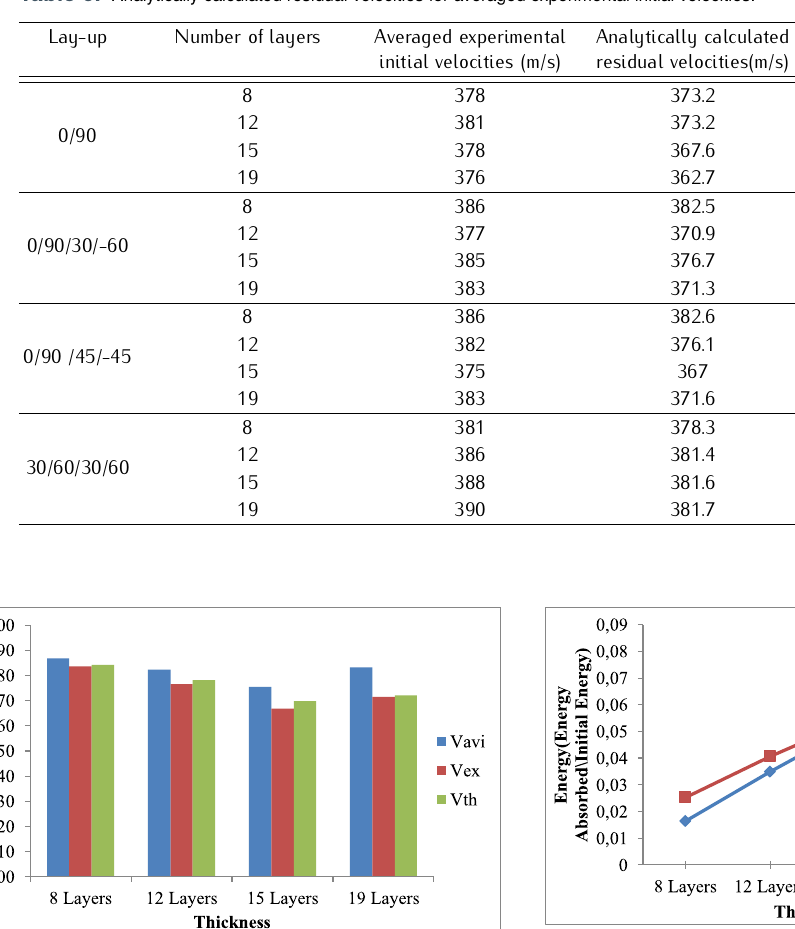
Table 6. Analytically calculated residual velocities for averaged experimental initial velocities.